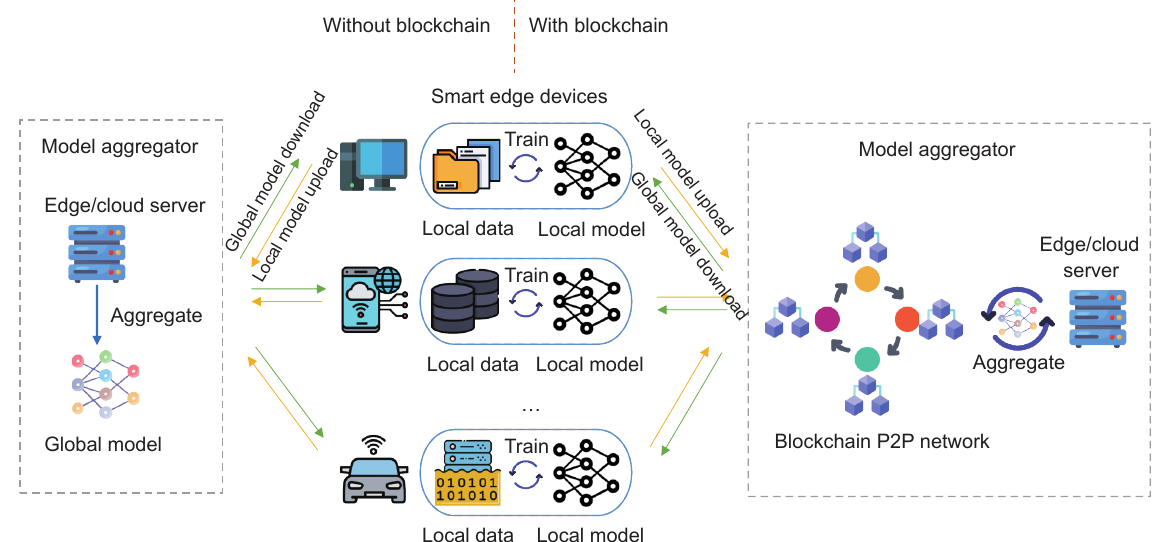
Fig. 8 Comparison between federated learning architecture with and without